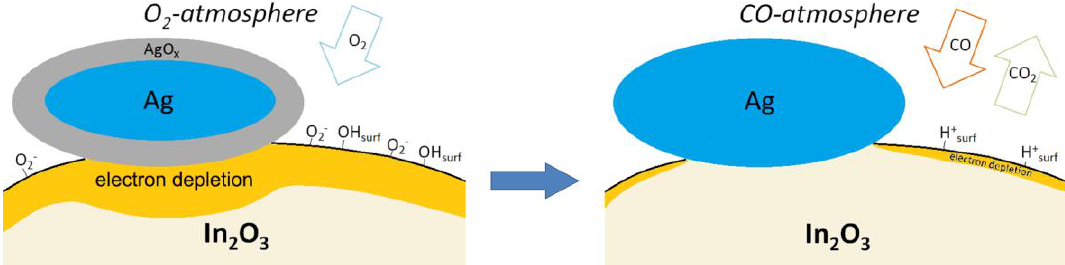
Figure 10. Schematic representation of the modifier effect on In 2 O 3 /Ag nanocomposites interaction with CO in air at room temperature.